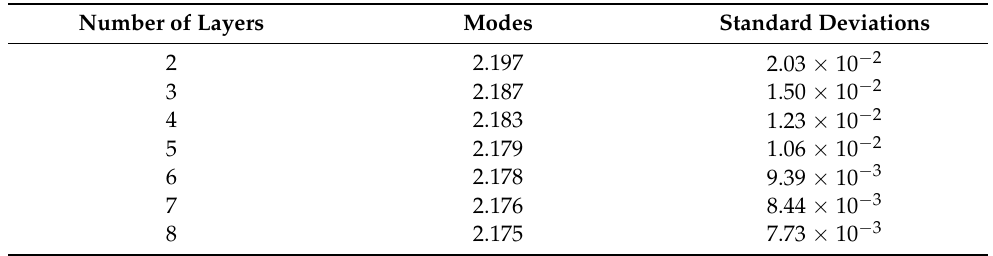
Table 4. Modes and standard deviations for the saturation density of 0.40 and the given number of layers.